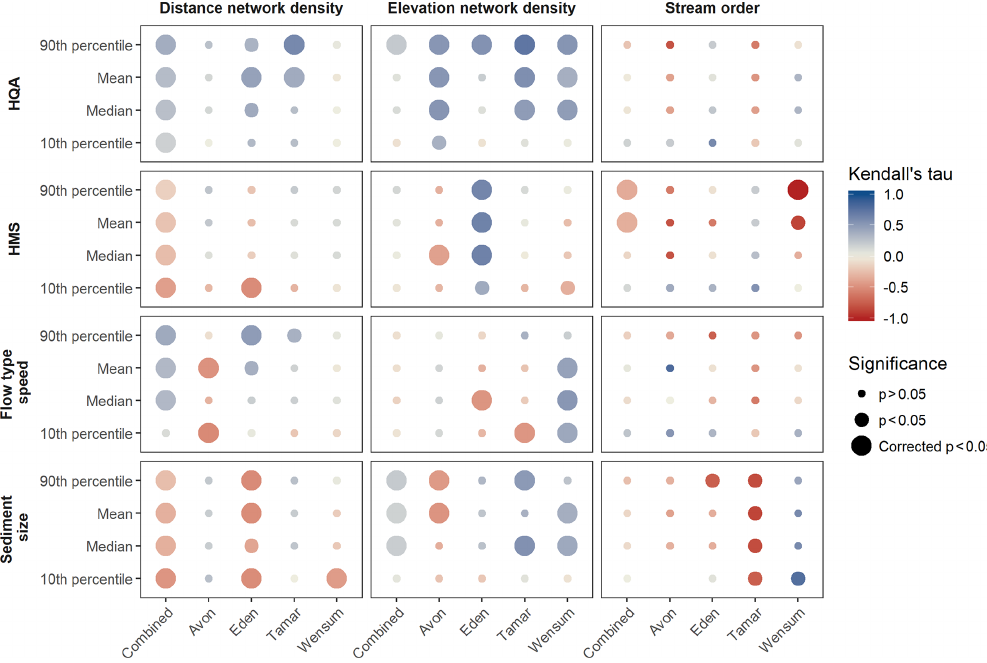
Figure 4. Summary of correlations between distance network density, elevation network density, stream order and RHS variables for all catchments combined and each individual catchment. Significance of correlation is indicated by point size with the largest points significant post p -value correction. Effect size (Kendall’s τ ) is indicated by colour. No correlation was possible between stream order and 10th percentile sediment size in the Avon due to no variation in the RHS